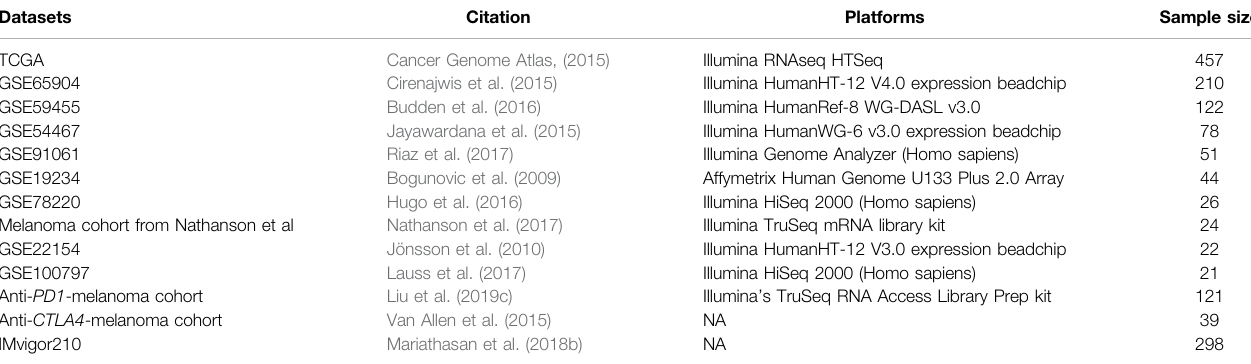
TABLE 1 | The sequencing platform and sample size of each